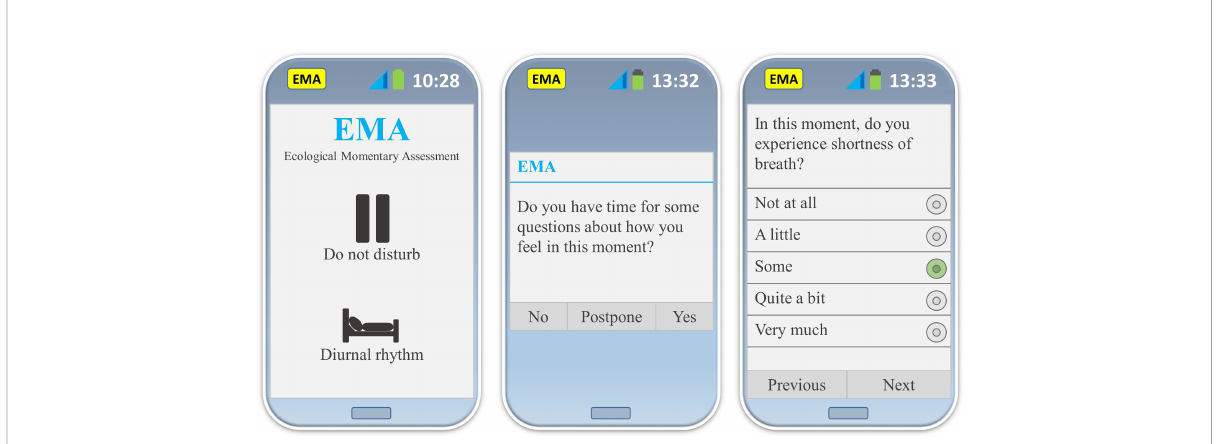
FIGURE 3 This fi gure illustrates three different user interfaces of the original smart phone app developed for EMA ThyPRO assessments (72). Left: it is possible to adapt the EMA assessments to the daily rhythm of the participants, and to pause EMA assessments (e.g. due to a business meeting). Middle: EMA noti fi cation. It is possible to postpone or decline EMA assessments on occasions where participants are unable to complete assessments. Right: EMA item with fi ve response categories (in this example ‘ Some ’ has been chosen). It is possible to see as well as change all previous answers until the EMA assessment is completed. App: application; EMA: ecological momentary